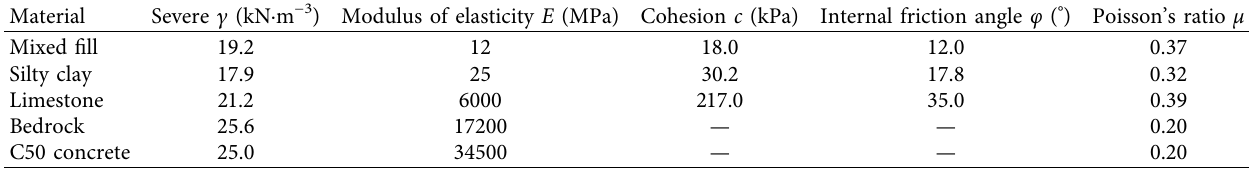
Figure 2: Finite element model of soil-rock combination field. Table 1: Structure and stratigraphic physical